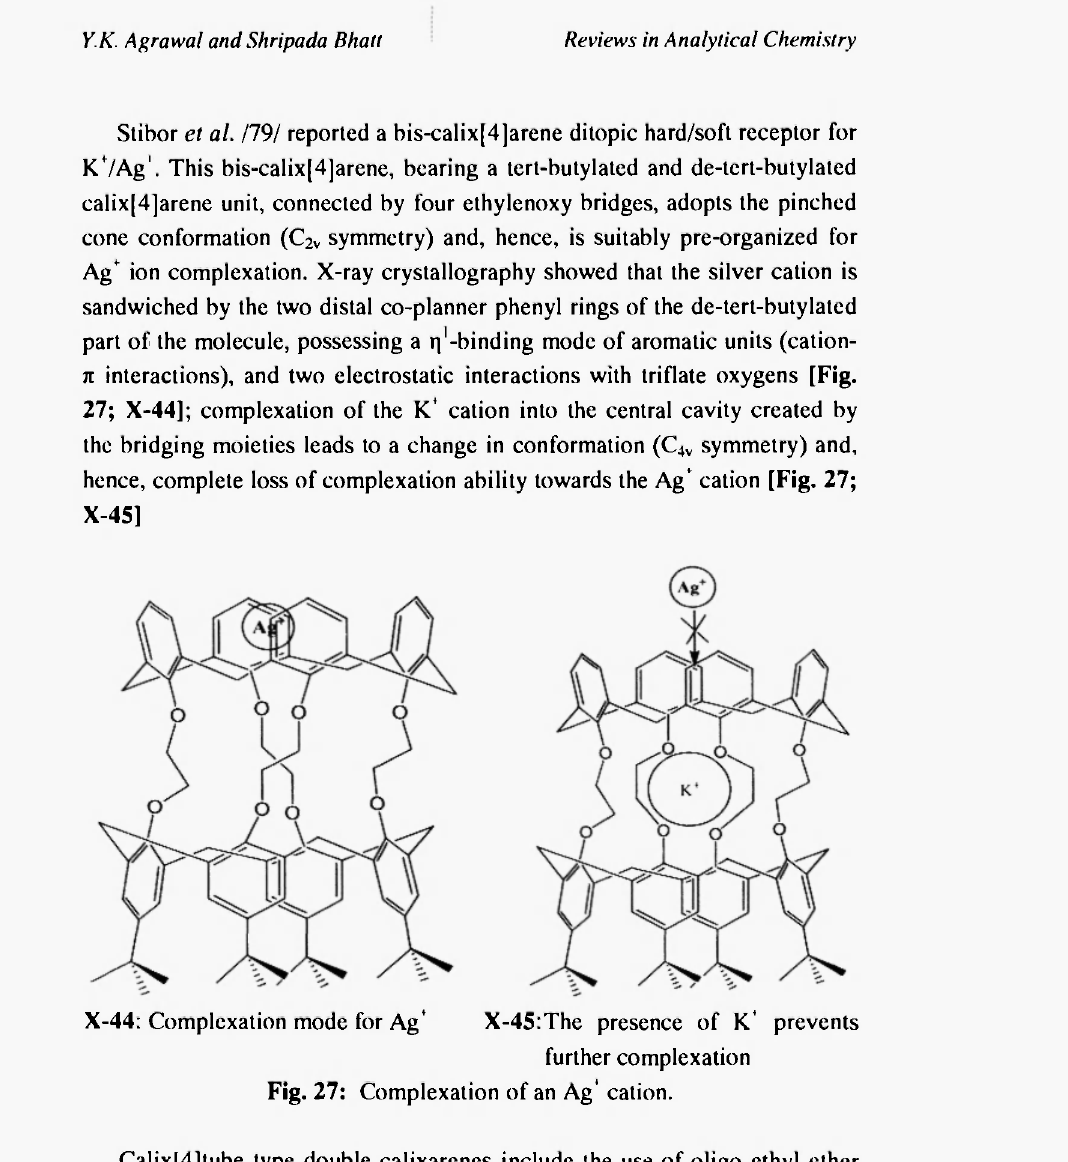
Fig. 27: Complexation of an Ag'